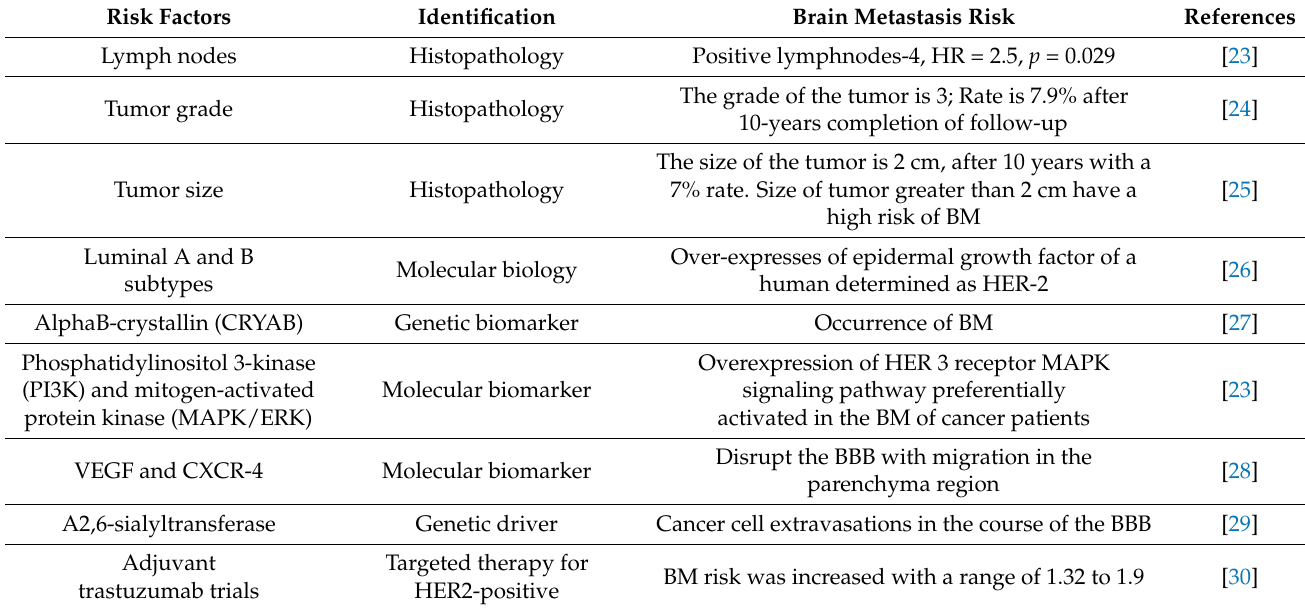
Table 1. Risk factors, identification, and chances of BM in BC